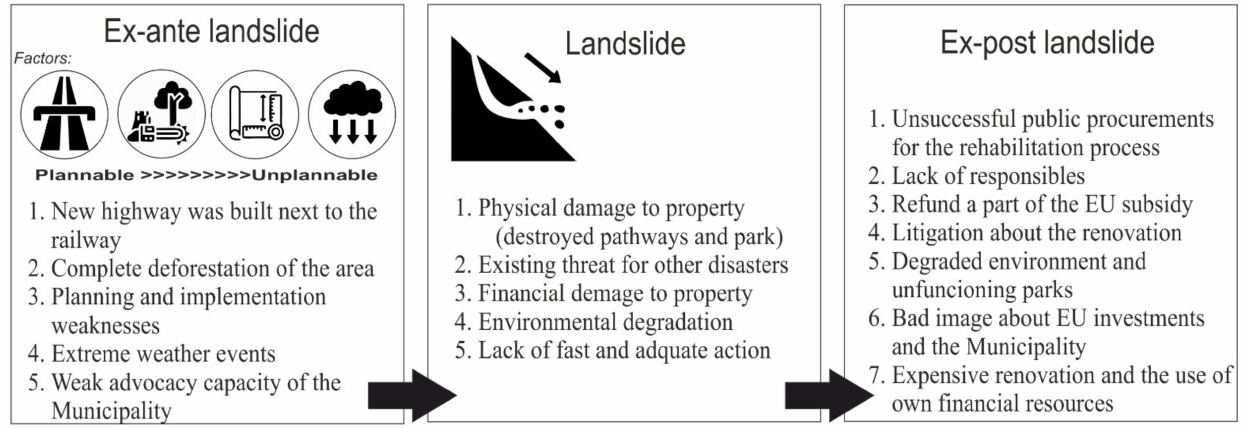
Figure 1. Framework of landslide process and outcomes used in this